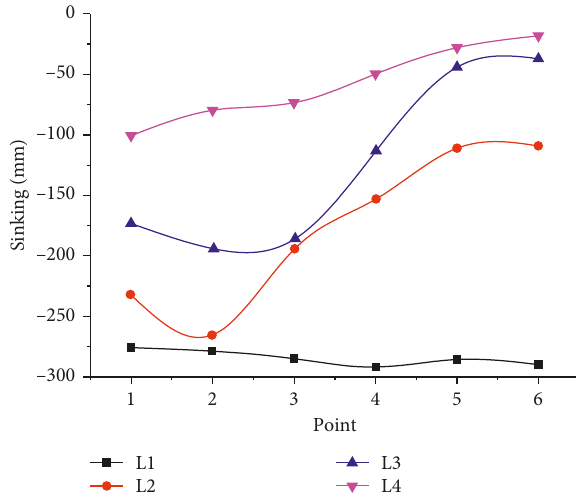
Figure 11: Subsidence with the caving